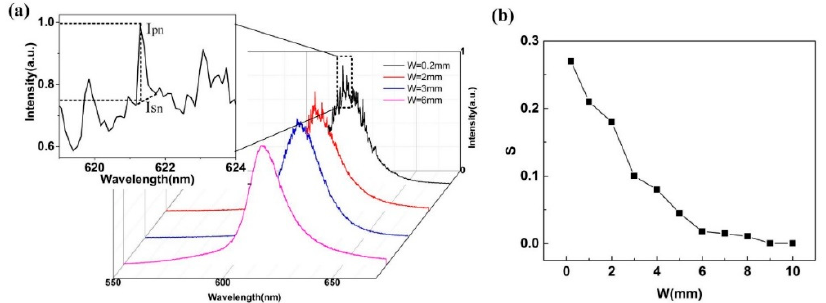
Figure 6. ( a ) The emission spectrum of the NPDDNLC sample at different widths (W) of pump area. The inset shows the enlarged view of the corresponding rectangle area. ( b ) The sharpness of the laser modes as a function of the width of pump area. The length of pump area is 10 mm and the pump energy density is about 0.54 mJ/cm 2 .